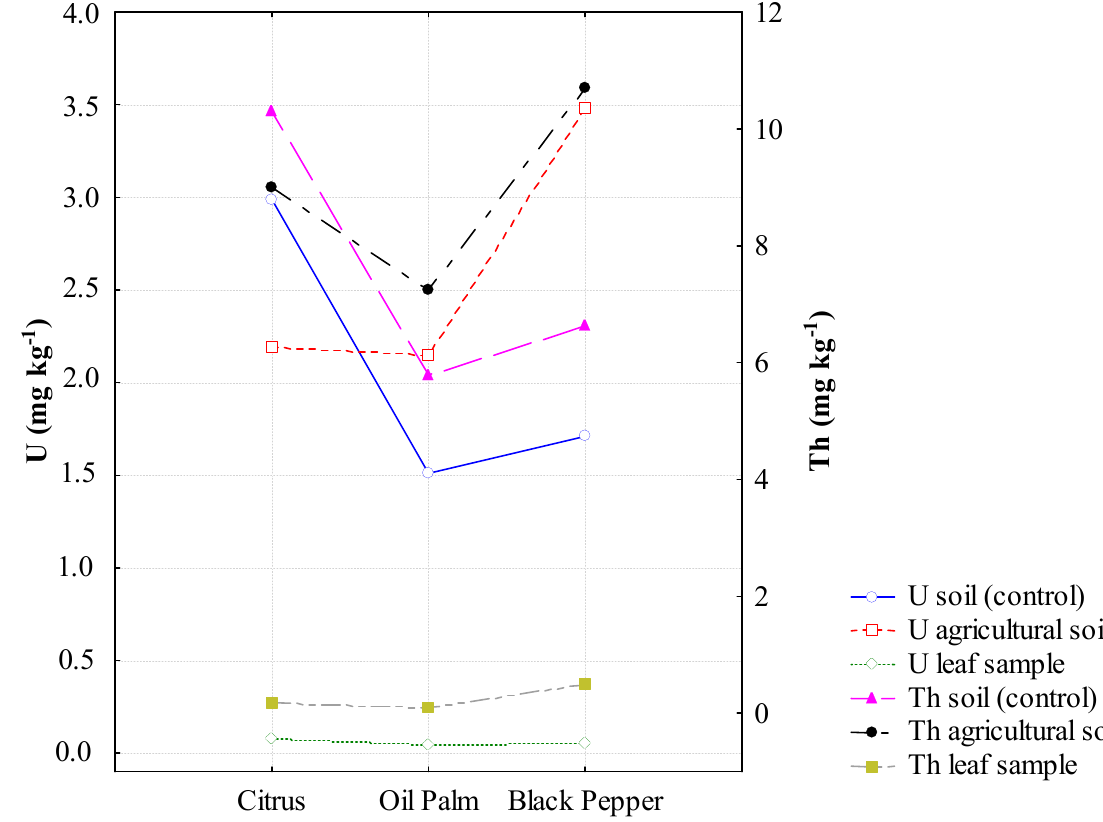
Figure 2. Uranium and Thorium in cultivated and reference (control) soils and in plant tissues.